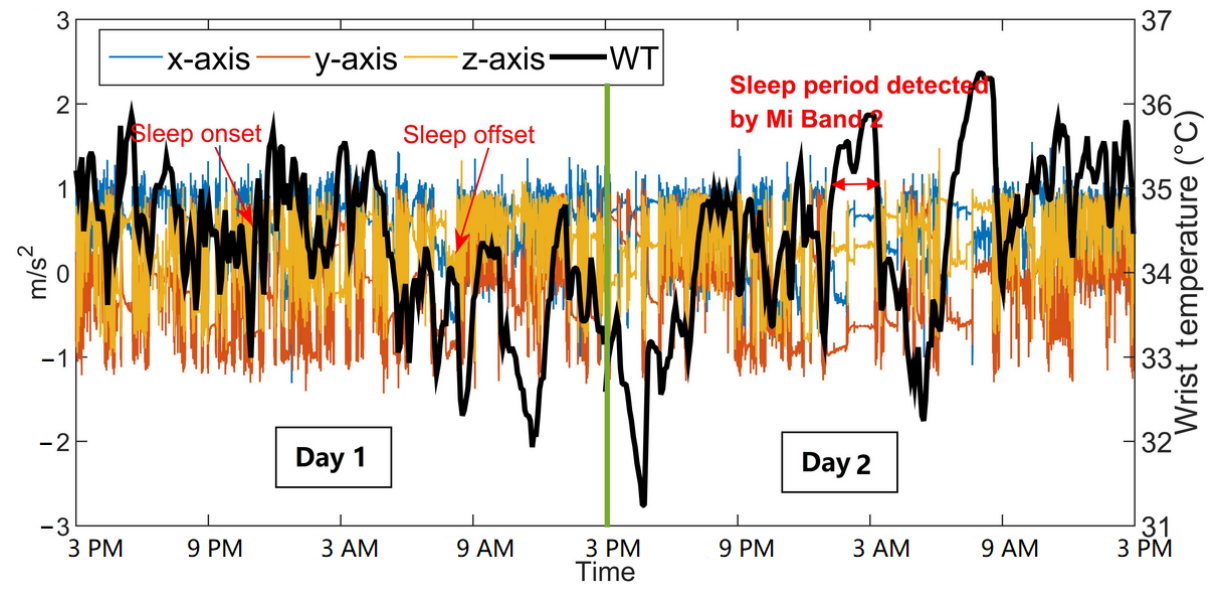
Figure 8. Two consecutive days of wrist temperature and AX3 data of older adults living with dementia 2. Sleep onset or offset were obtained from the recreated sleep journal. WT: wrist